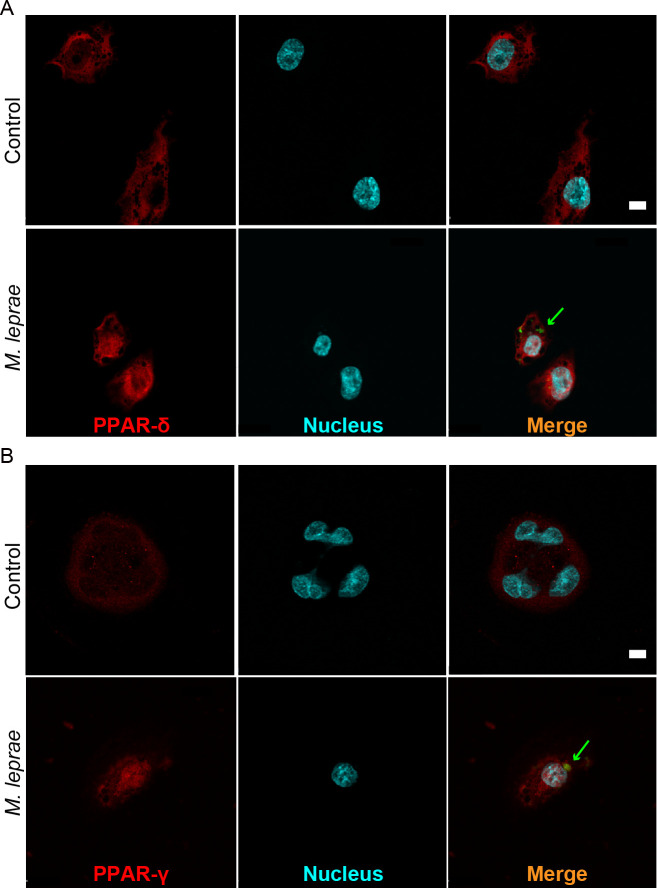
Nuclear translocalization of PPAR-δ and PPAR-γ proteins occur after M. leprae infection.THP-1 cells grown on glass coverslips in 24-well plates were infected with FITC-conjugated M. leprae (MOI = 100), indicated by green arrows, for 48 h, followed by immunofluorescence staining for PPAR-δ or PPAR-γ (red). Nuclei were counterstained with Hoechst 33258 (blue). Bars: 10 μm.